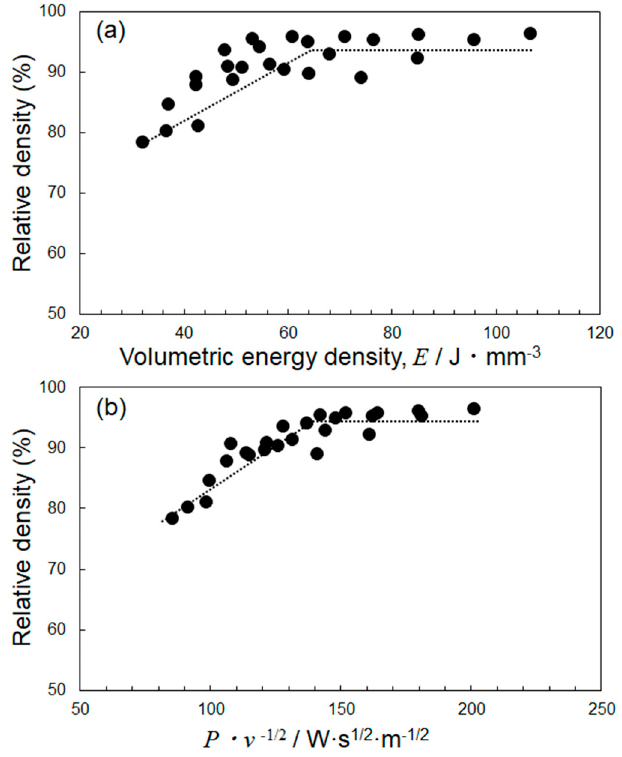
Figure 11. Relative density as functions of ( a ) the volumetric energy density ( E ) and ( b ) P · v − 1 based on the deposited energy density.